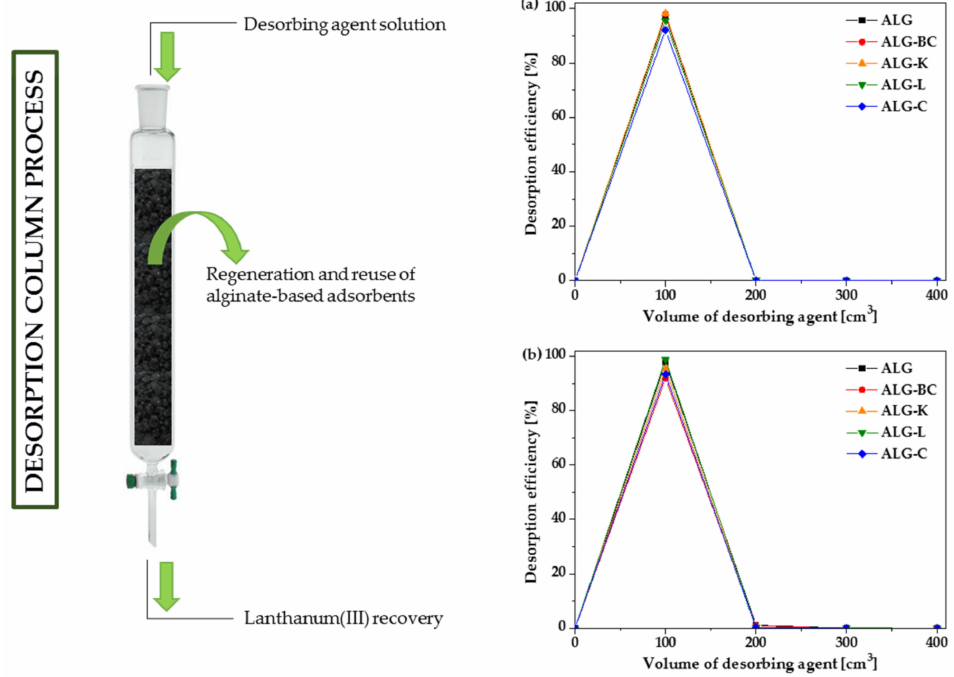
Figure 8. Desorption column results for the alginate-based adsorbents using ( a ) 50 mg/dm 3 La(III), ( b ) 100 mg/dm 3